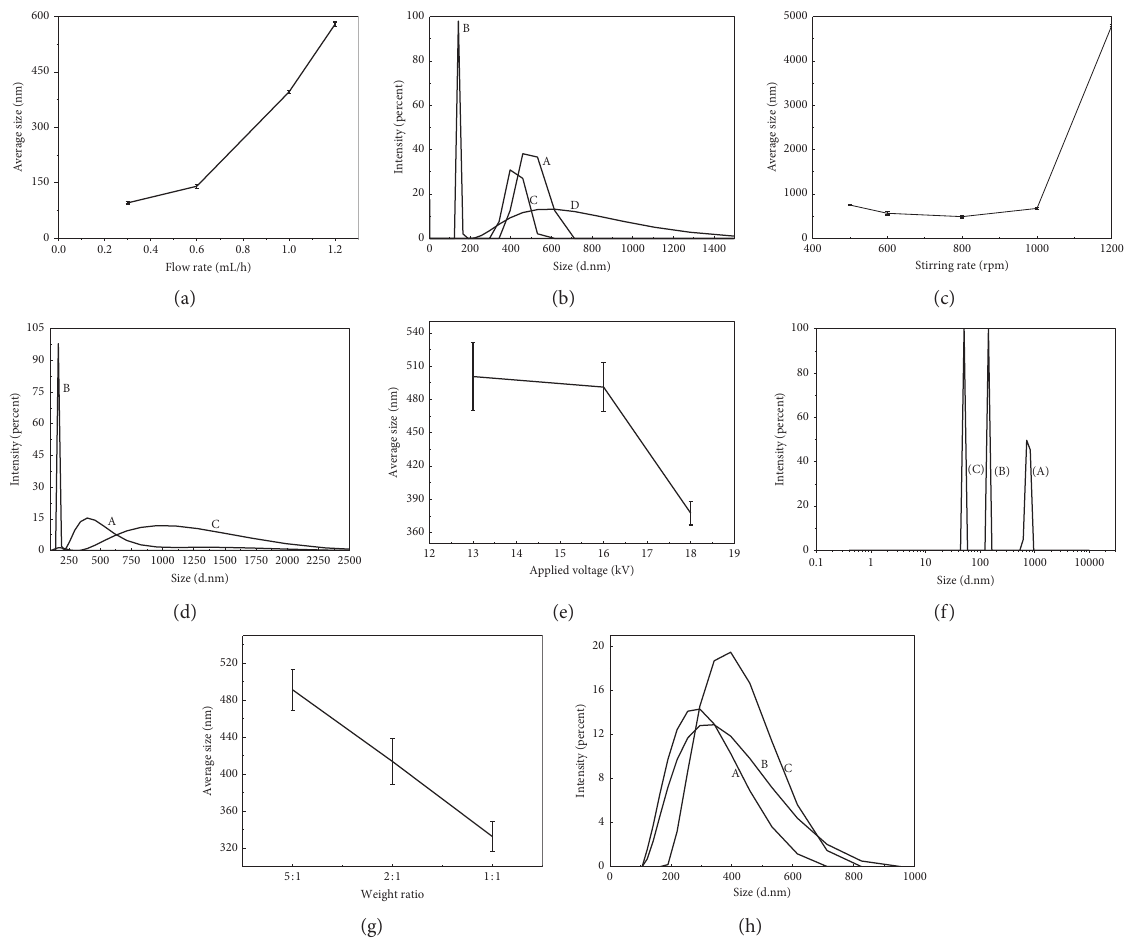
Figure 3: The average sizes (a) and size distributions (b) of the SA/chitosan particles loaded with CS at different flow rates of (A) 0.3mL/h; (B) 0.6mL/h; (C) 1.0mL/h; (D) 1.2mL/h. Average sizes (c) and size distributions (d) of the SA/chitosan particles loaded with CS at different stirring rates of (A) 600rpm; (B) 800rpm; (C) 1000rpm. Average sizes (e) and size distributions (f) of the SA/chitosan particles loaded with CS at different applied voltages of (A) 13kV; (B) 16kV; (C) 18 kV. Average sizes (g) and size distributions (h) of the SA/chitosan particles loaded with CS at different weight ratios of SA to CS of (A) 5:1; (B) 2 :1; (C) 1:1.